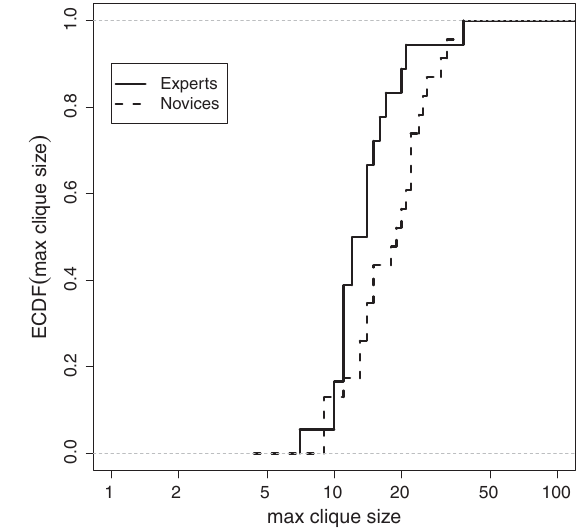
FIG. 4. Number of 3-cycles. This is the distribution of the number of 3-cycles for experts and novices. A Kolmogorov- Smirnov test suggests that experts and novices are not distin- guishable based on their 3-cycle distributions ( p ¼ 0 : 1584